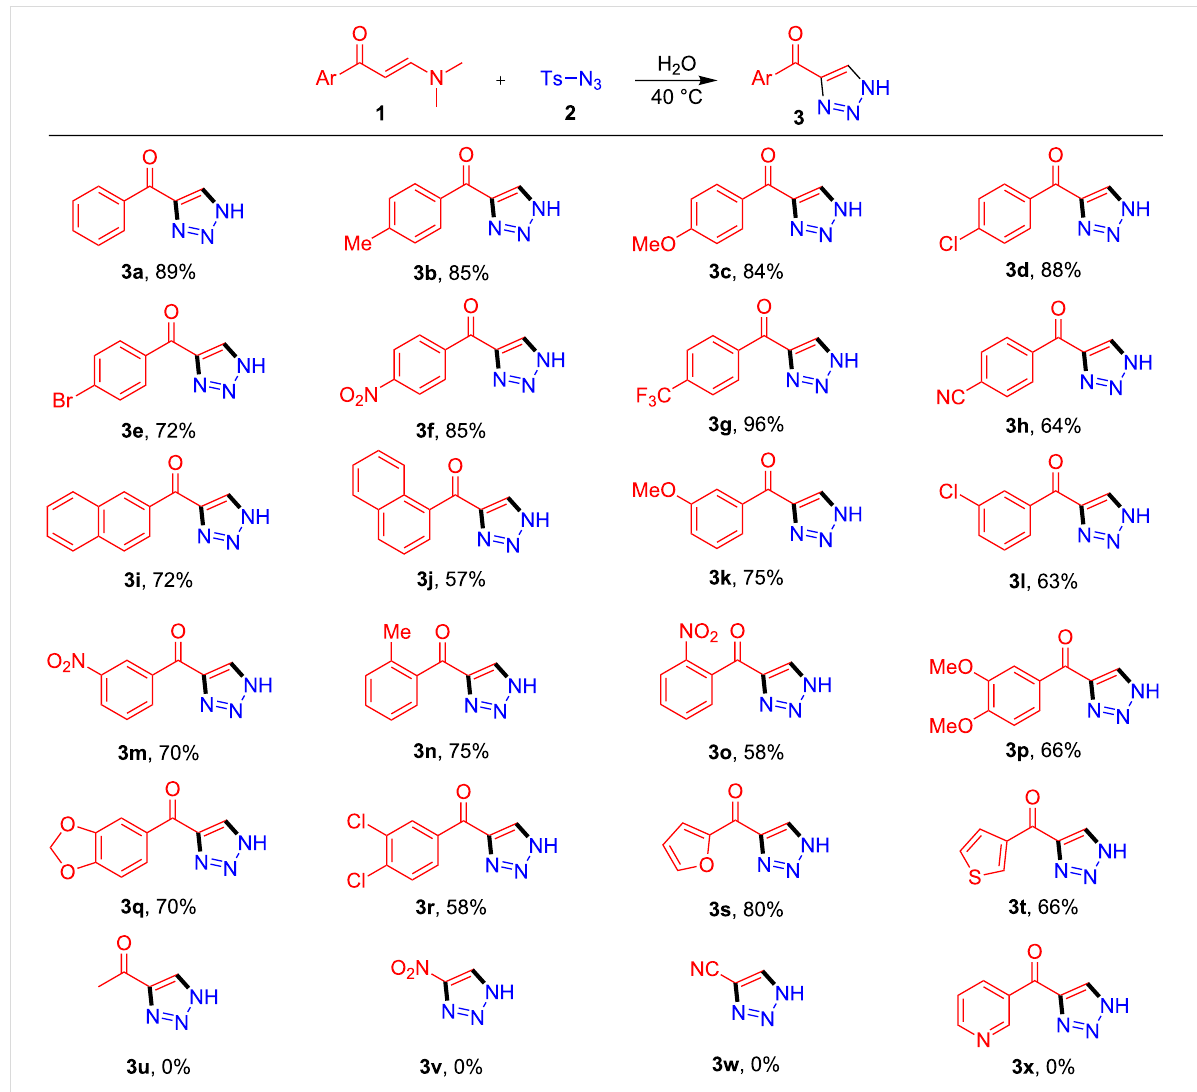
Figure 1: Scope of the water-mediated synthesis of 4-acyl- NH -1,2,3-triazoles. General conditions: enaminone 1 (0.2 mmol), tosyl azide 2 (0.3 mmol) and water (2 mL), stirred at 40 °C for 20 h (yields of isolated products are based on 1 ).